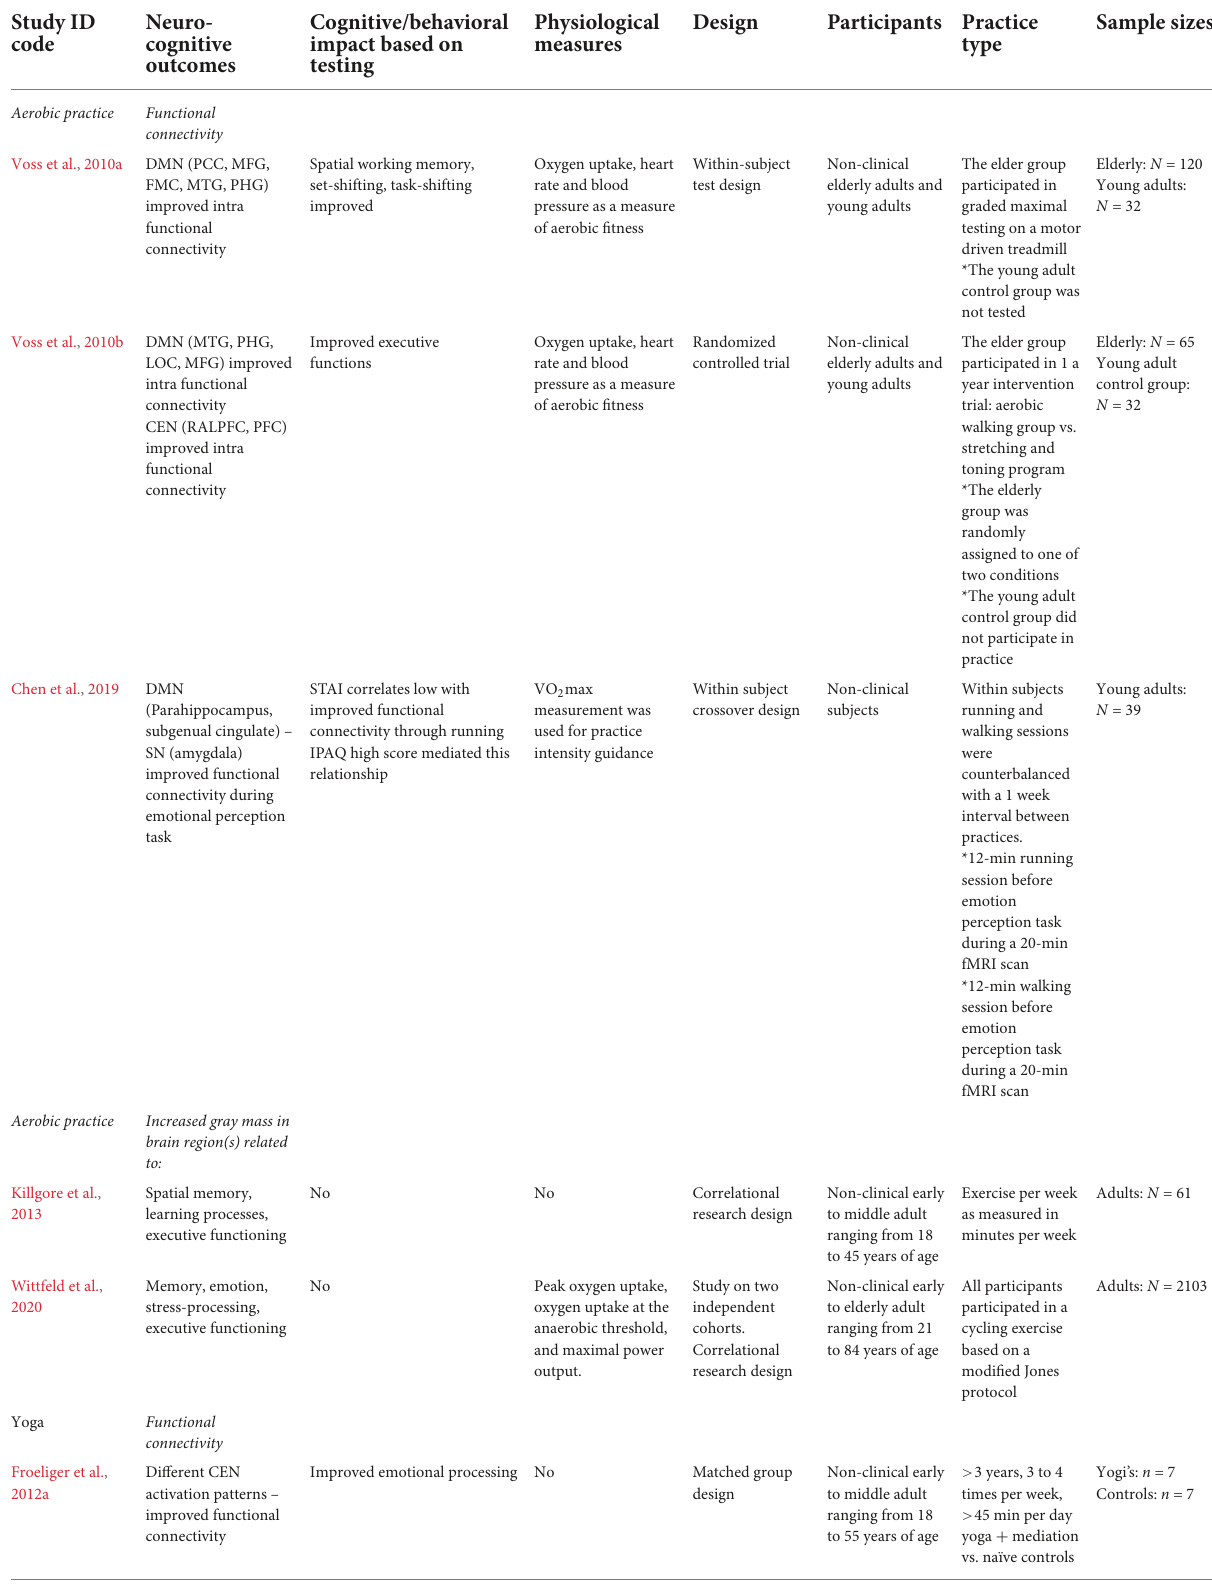
TABLE 3 Physical exercise: experiential learning effects found and characteristics of included neurocognitive studies for aerobic practice and yoga. Study ID